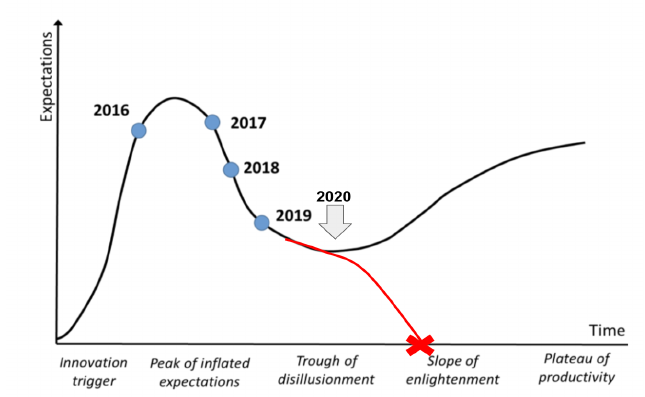
Figure 1: The Gartner Hype Cycle reproduced from [2] and modified.